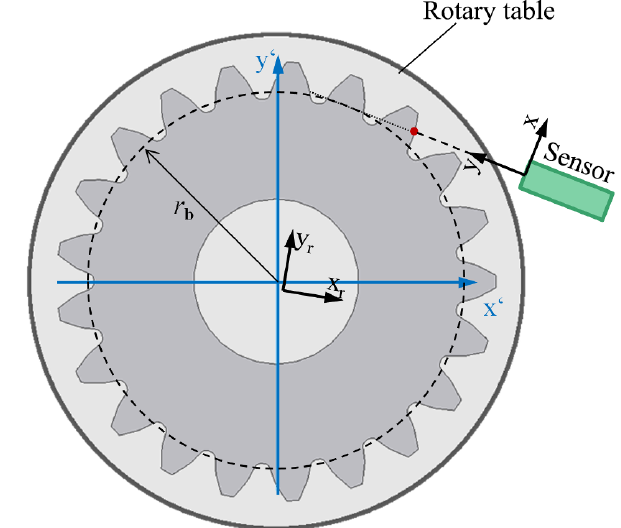
Figure 2. Multi-distance measurement principle consisting of a sin- gle distance sensor ( x , y ) in combination with a rotary table ( x r , y r ) measuring continuously the surface of a spur gear ( x (cid:48) , y (cid:48) ) depending on the rotation